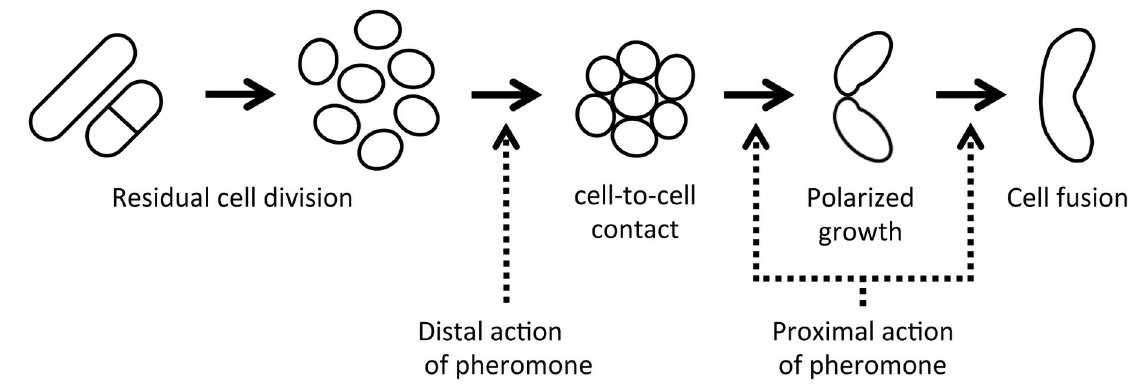
Figure 9. Illustration of the mating steps regulated by the distal and proximal actions of M-factor mating pheromone in liquid culture. When haploid cells of the opposite mating types are mixed in nitrogen-free liquid medium, cell agglutination occurs after arrest of cell division. Mating type-dependent cell-to-cell adhesion is induced in cell aggregates. From the contact site, polarized tip growth occurs leading to cell fusion. Pheromone is required for steps of cell agglutination (distal action), polarized growth and cell fusion (proximal